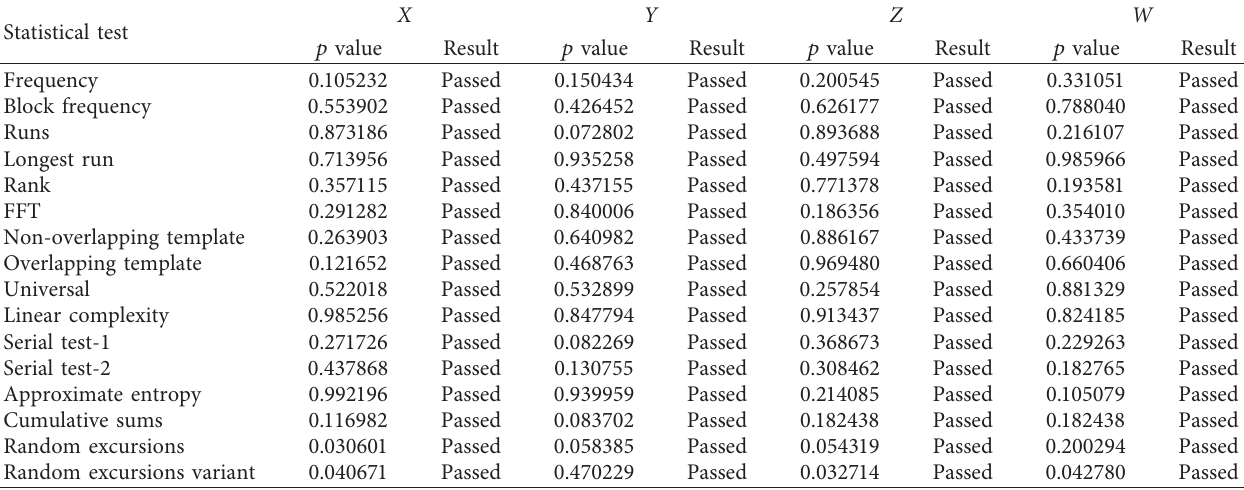
Table 5: NIST statistical test